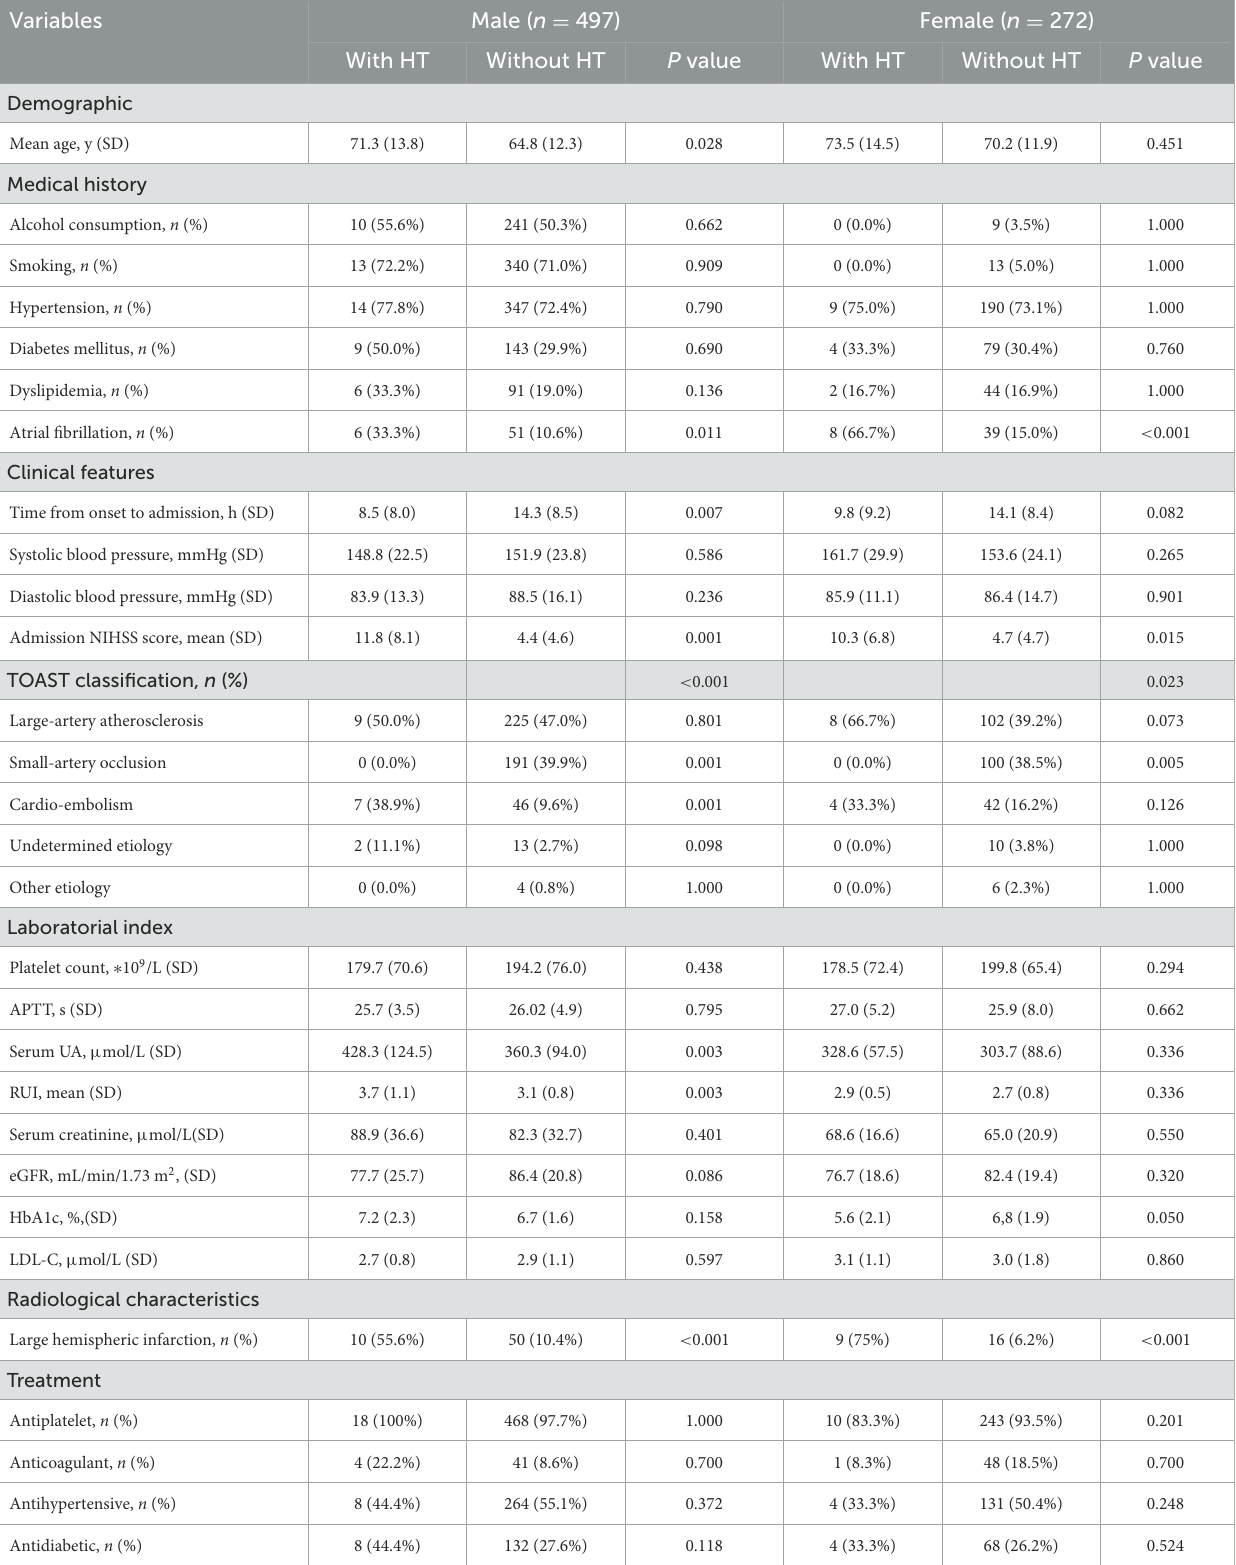
TABLE 2 Univariate analysis to identify risk factors of spontaneous